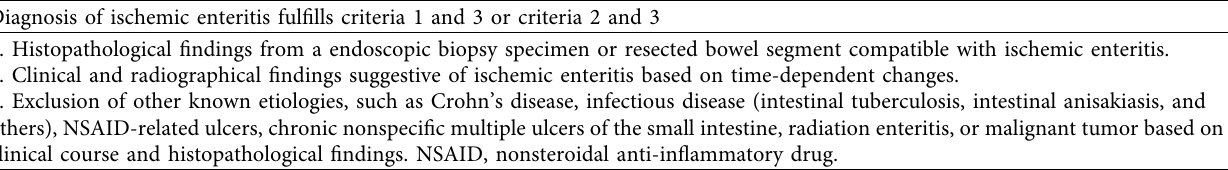
Table 1: Conventional diagnostic criteria.